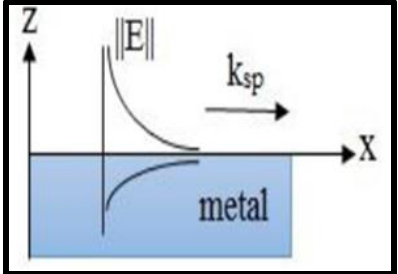
Figure 2. The exponential decay of the electromagnetic fields on every side of the